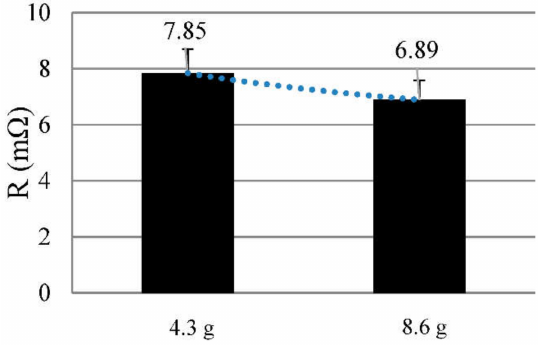
Figure 6. Contact resistance with different quantities of